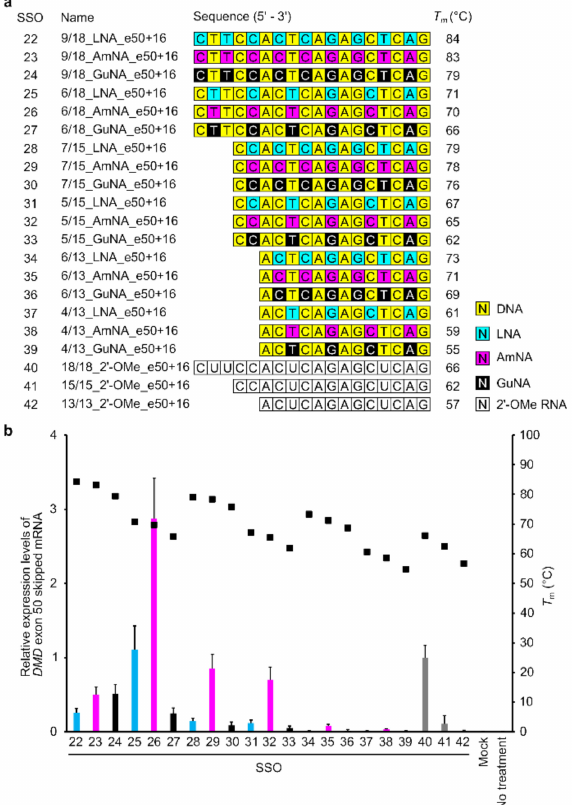
Figure 4. Design and evaluation of 13- to 18-mer LNA/AmNA/GuNA/2 (cid:48) -OMe RNA-modified SSOs targeting DMD exon 50 and having different lengths and modification content using stably transfected cells. ( a ) Schematic representation of 13- to 18-mer LNA, AmNA-, and GuNA, and 2 (cid:48) -OMe RNA-modified SSOs designed for the assay. ( b ) RT-qPCR analysis results. Stable-e50 cells were transfected with the indicated SSOs (10 nM) for 24 h. On the x axis of the graph, transfected SSOs are shown with SSO numbers mentioned in ( a ). The expression of exon 50-skipped mRNA was measured by RT-qPCR (bar). The expression was normalized to the RPLP2 mRNA signal, relative to the value of 18/18_2 (cid:48) -OMe_e50+16 (SSO40) set to 1. Values represent the mean ± standard deviation of three independent experiments performed in duplicate. T m value of SSOs was measured from 5 to 94.5 ◦ C (black box). Mock: treated with Lipofectamine only; no treatment: no transfection. Values represent the mean ± standard deviation of three independent